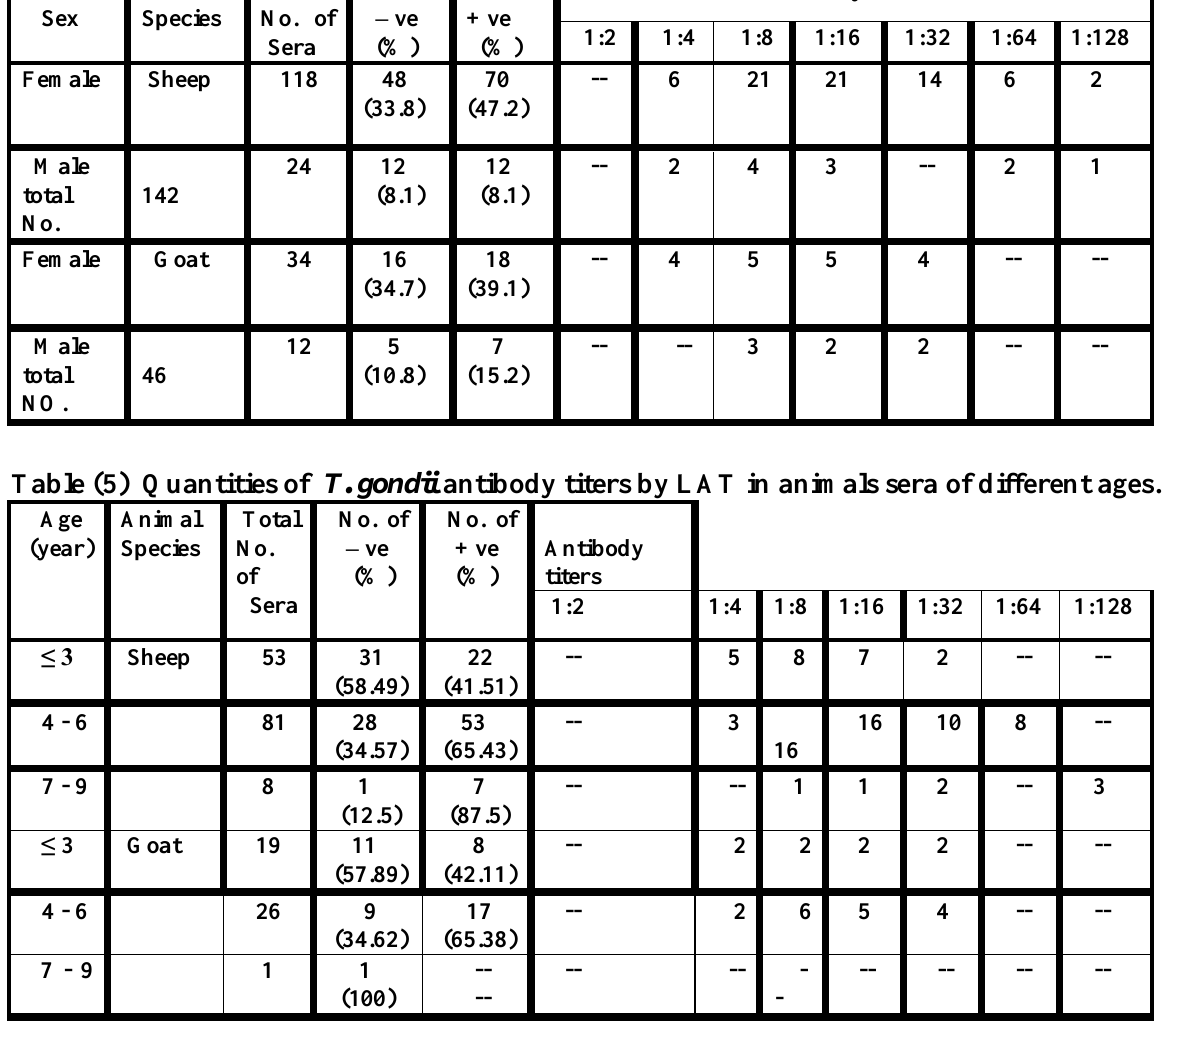
Table (4) Quantities of T. gondii antibody titers by LAT in animals sera between sexes. Animal